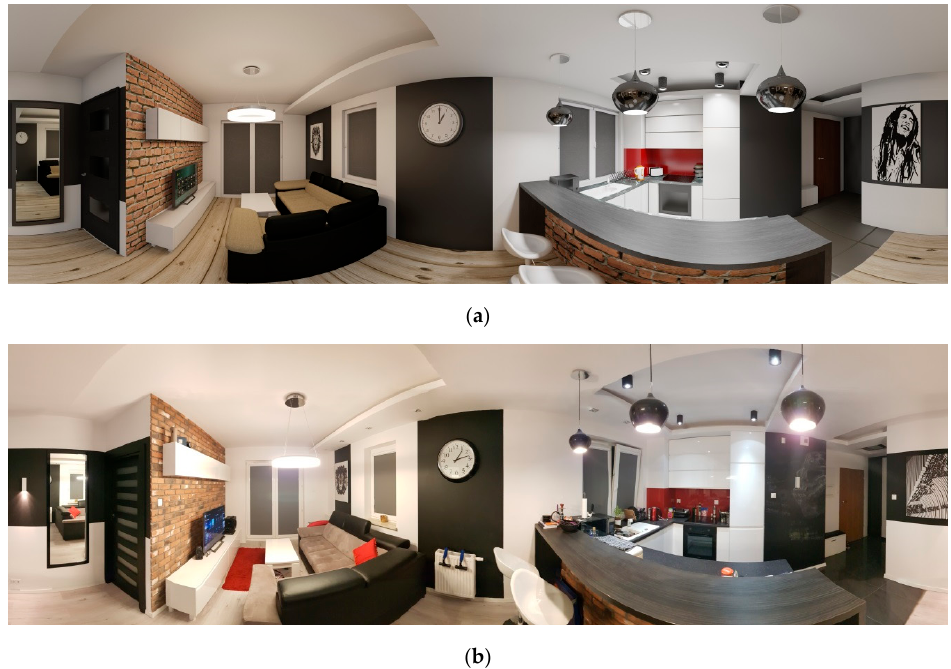
Figure 2. Panoramic rendering of: ( a ) virtual and ( b ) photograph of real room [62]. Energies 2020 , 13 , x FOR PEER REVIEW